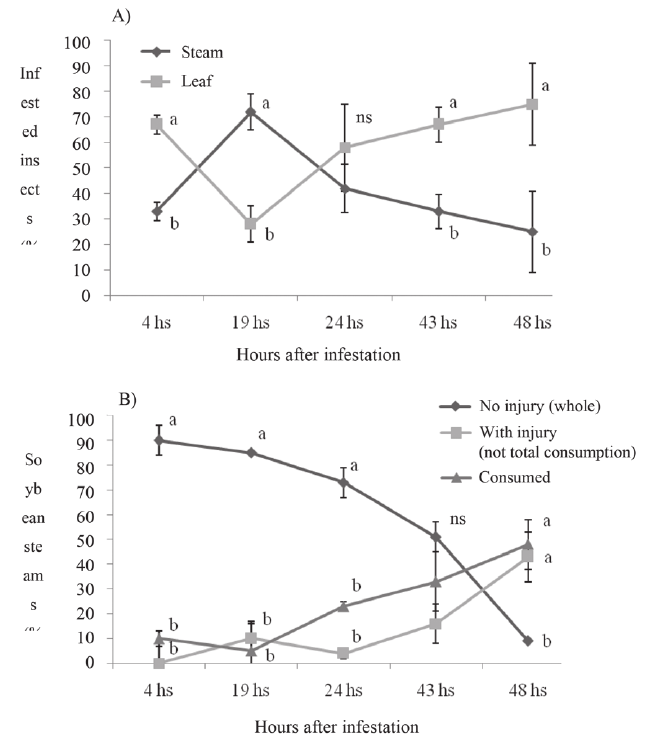
Figure 1 - A) Proportion of caterpillars found on completely expanded soybean leaf or in the area of terminal growth (steams) of the young soybean plant (stage V3) conventional (non- Bt ). Mean ± EPM followed by the same letter in the column of the same stage of insect development do not differ according to the student’s t -test (Figure 1A) and Tukey’s test (p≤0.05). (ns = no statistical difference). Analyses were performed on data transformed into ( √ X +